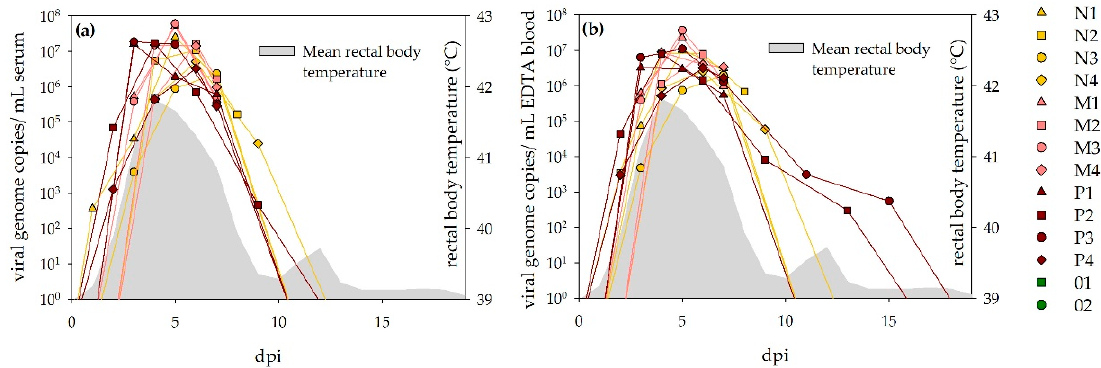
Figure 3. Viremia detected via RT-qPCR in sheep: Results for serum ( a ) and EDTA ( b ) are depicted, respectively. Both curves are comparable between the different dosage groups and sample sources. For two animals (P3, P4), virus was detected in EDTA blood for significantly longer than in the corresponding serum samples. The viremic state coincided well with the fever period (grey pattern).